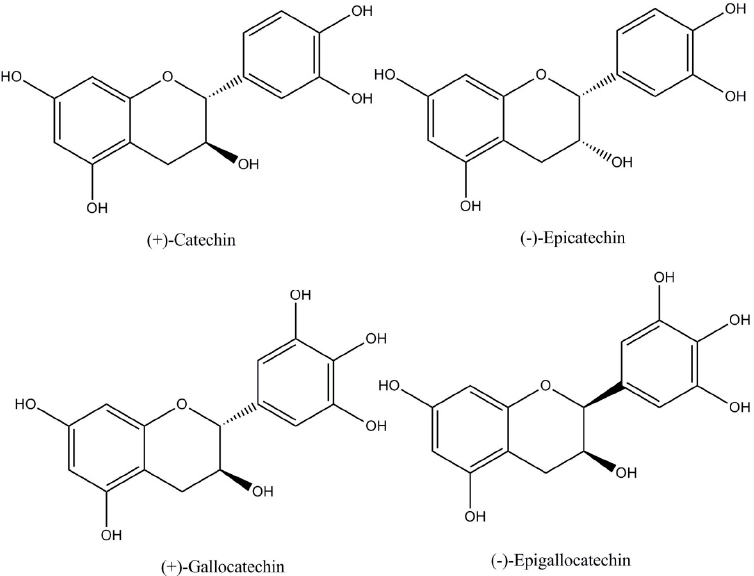
Figure 1. Cocoa flavanols.